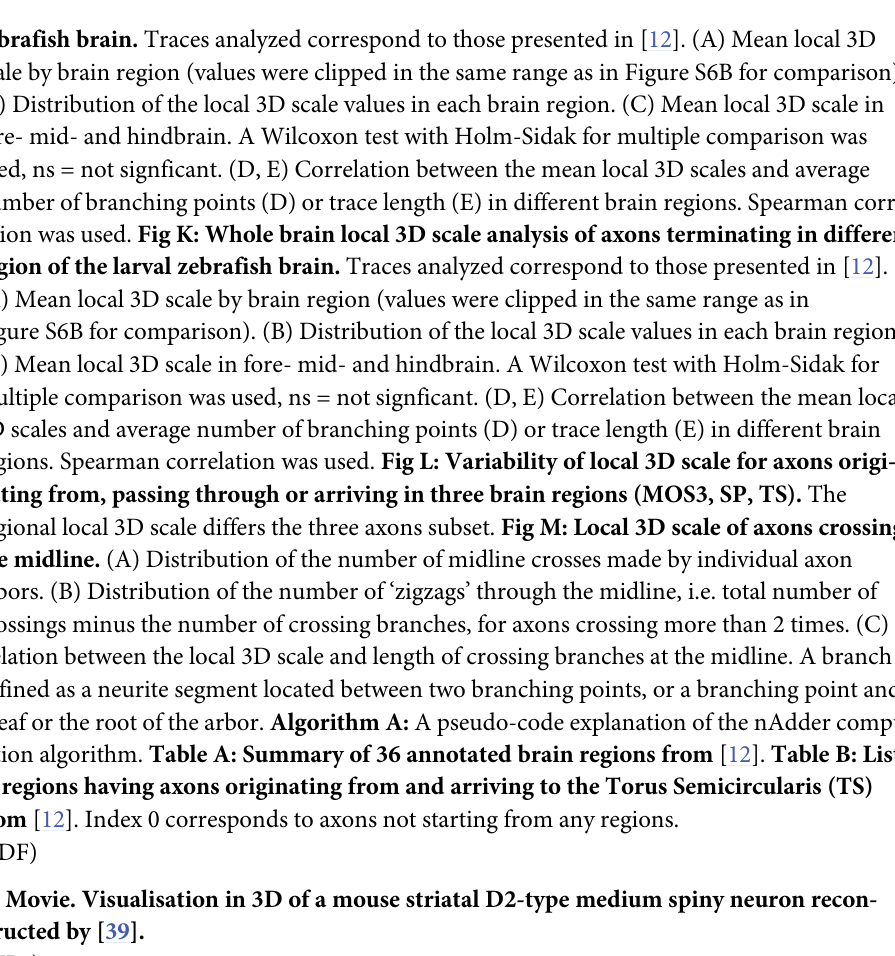
tation algorithm. Table A: Summary of 36 annotated brain regions from [12]. Table B: List of regions having axons originating from and arriving to the Torus Semicircularis (TS) from [12]. Index 0 corresponds to axons not starting from any